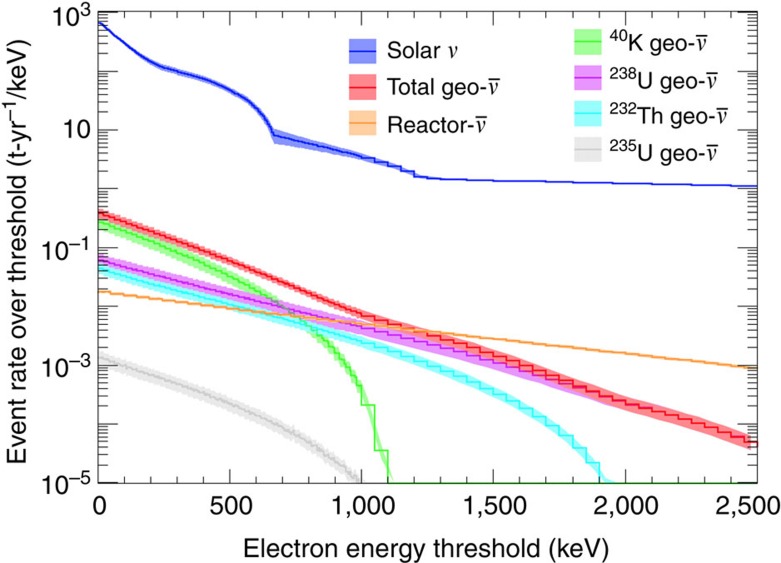
Predicted event rate over threshold per tonne-year exposure.Event rates over threshold shown here versus electron energy threshold (keV) for solar neutrino (blue), geo-neutrino (red) and reactor antineutrino (orange) events, assuming a CF4 target and 45% probability of oscillation into νμ or ντ. Individual contributions to the total geo-neutrino flux from 40K (green), 238U (violet), 232Th (teal), and 235U (grey) decays are also shown. Geo-neutrino and reactor antineutrino rates are calculated using the normalizations at Gran Sasso from Table 1 and Supplementary Table 2, respectively. Error bands shown here correspond to uncertainties given in Supplementary Tables 3 and 4. Event rates are ∼0.4% higher for a SF6 target, or 13.8% lower for a Xe target.